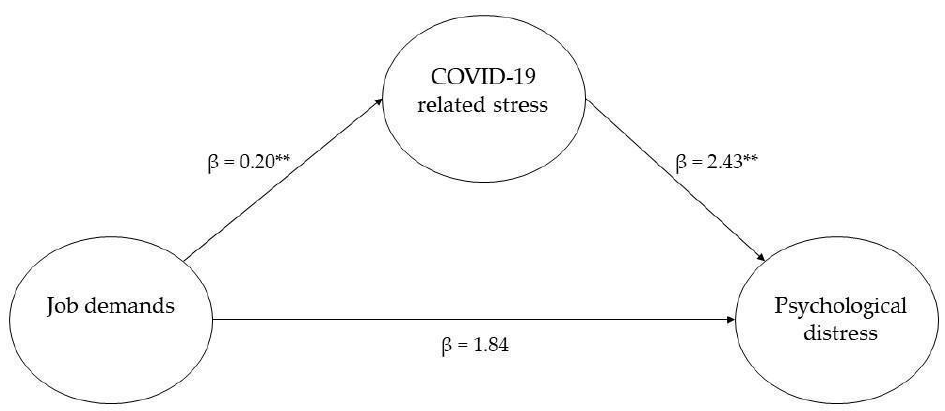
Figure 3. COVID-19-related post-traumatic stress as a mediator between job demands and psychological distress. Note: N = 275, ** p < 0.01.